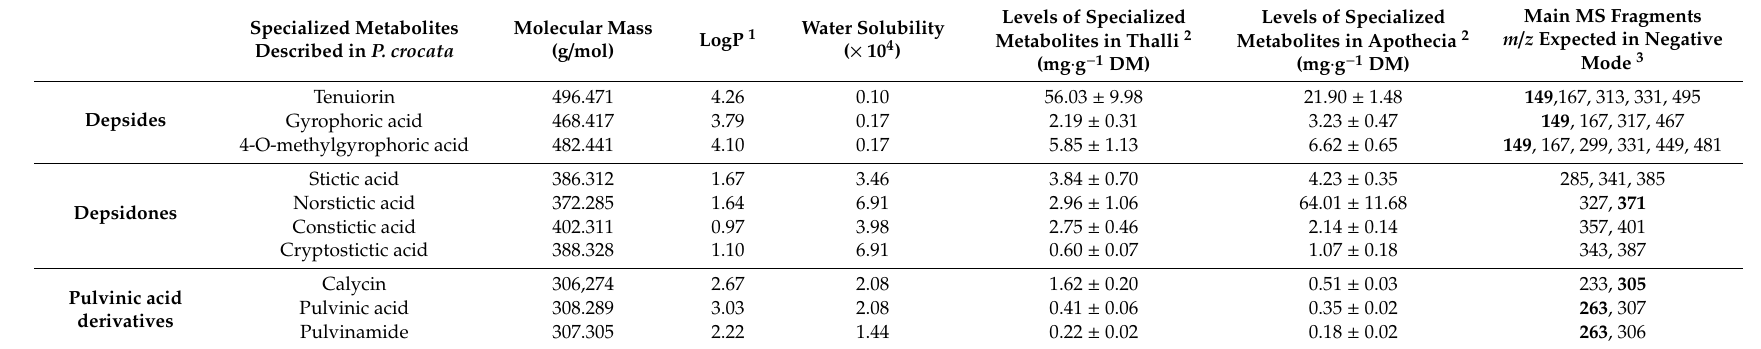
Table 1. Main phenolic specialized metabolites families: quantification in the acetone extracts of thalli, soralia, and apothecia, including physicochemical properties and fragmentation in negative